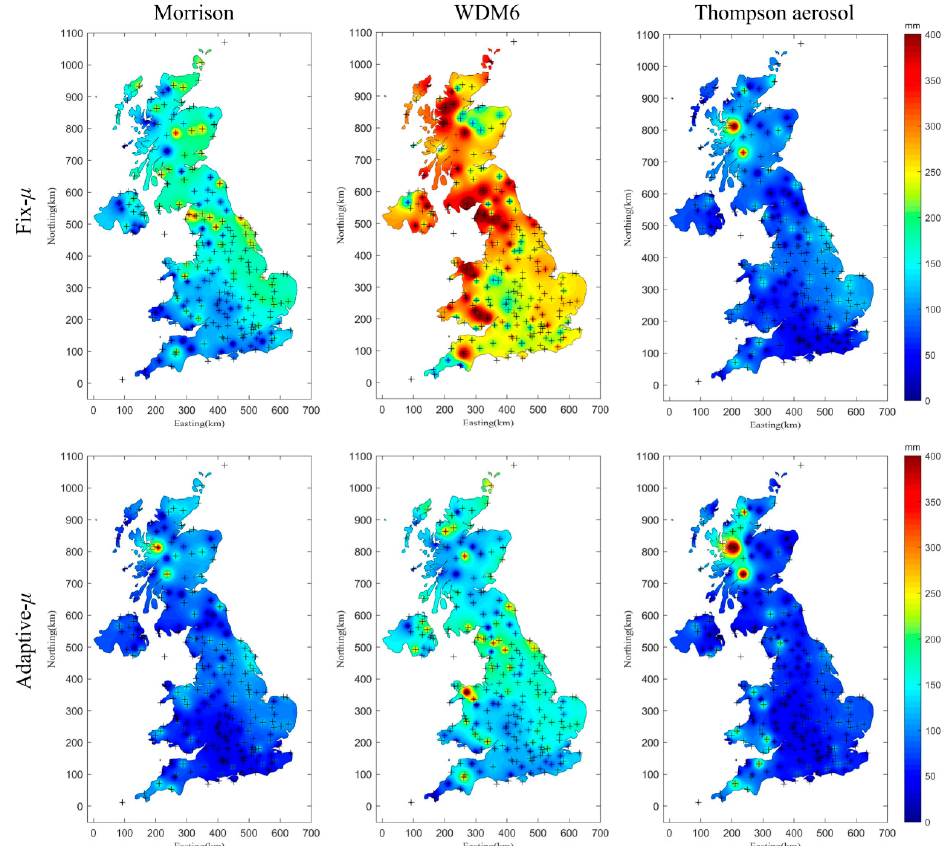
Figure 9. The absolute value of annual rainfall amount difference between the WRF simulation and rain gauge using fixed- 𝜇 and adaptive- 𝜇 RSD models of three double-moment schemes in 2013, plus symbols indicate the rain gauge positions.